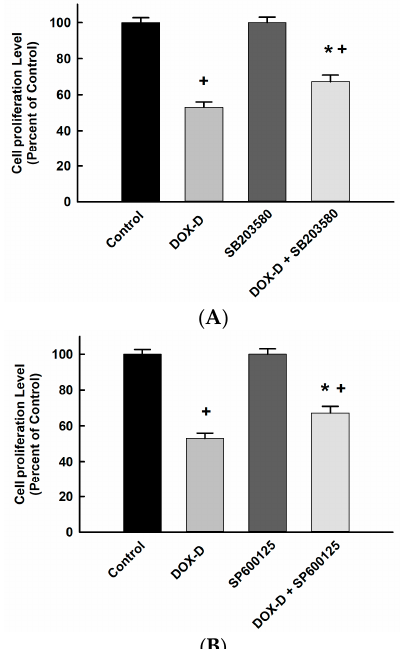
Figure 8. Effect of MAPK inhibitors on DOX-Vit D-induced cytotoxicity. MG63 cells were treated